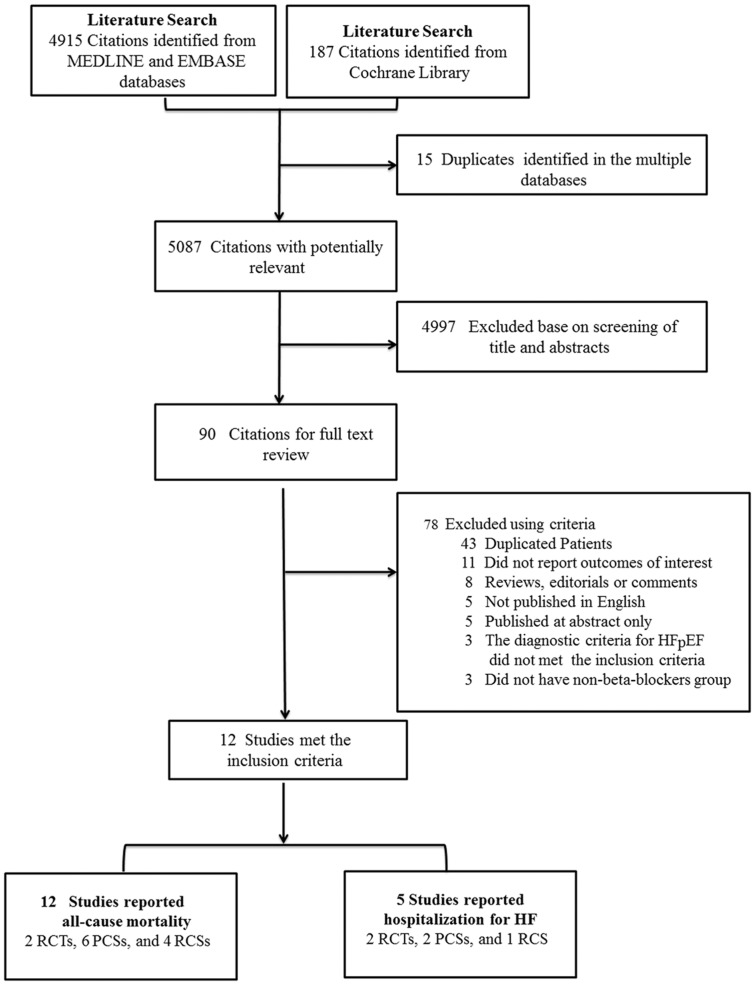
Flowchart of study search and selection in this meta-analysis.PCSs, prospective cohort studies; RCSs, retrospective cohort studies; RCTs, randomized controlled trials;